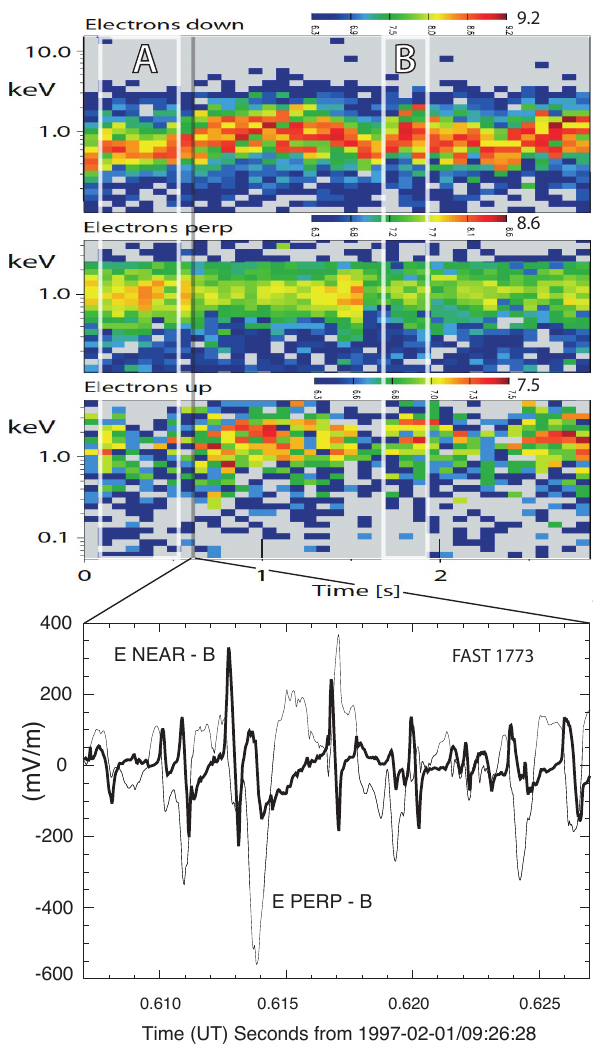
Fig. 4. Electron energy fluxes and waveform data from the shaded slice in Fig. 3 shown in the highest available resolution. The two stripes labelled A and B have been used for determining average distributions in Fig. 5. Top panel: downward electrons (within an angle of ± 11 ◦ parallel to the magnetic field) The energy flux in the most intense events is ∼ 6 . 4 × 10 − 4 1(cid:15) Jm − 2 s − 1 , with 1(cid:15) ∼ 1–3 (in keV) the bandwidth of the electron energy. Second panel: per- pendicular electrons. Third panel: upward (reflected) electrons. Note the differences in the colour bars. Upward electron fluxes are roughly two orders of magnitude weaker than downward. Per- pendicular (trapped) electron fluxes are about one order of magni- tude weaker taking into account that the colours do not reach sat- uration. Bottom panel: a 20ms snapshot of low-frequency electric wave form parallel and perpendicular to the magnetic field show- ing the bipolar parallel and unipolar perpendicular electric fields of several electron holes crossing the FAST spacecraft. Their tempo- ral width is 1t ∼ 5ms. These structures cannot be resolved by the electron instrument whose time resolution is roughly ∼